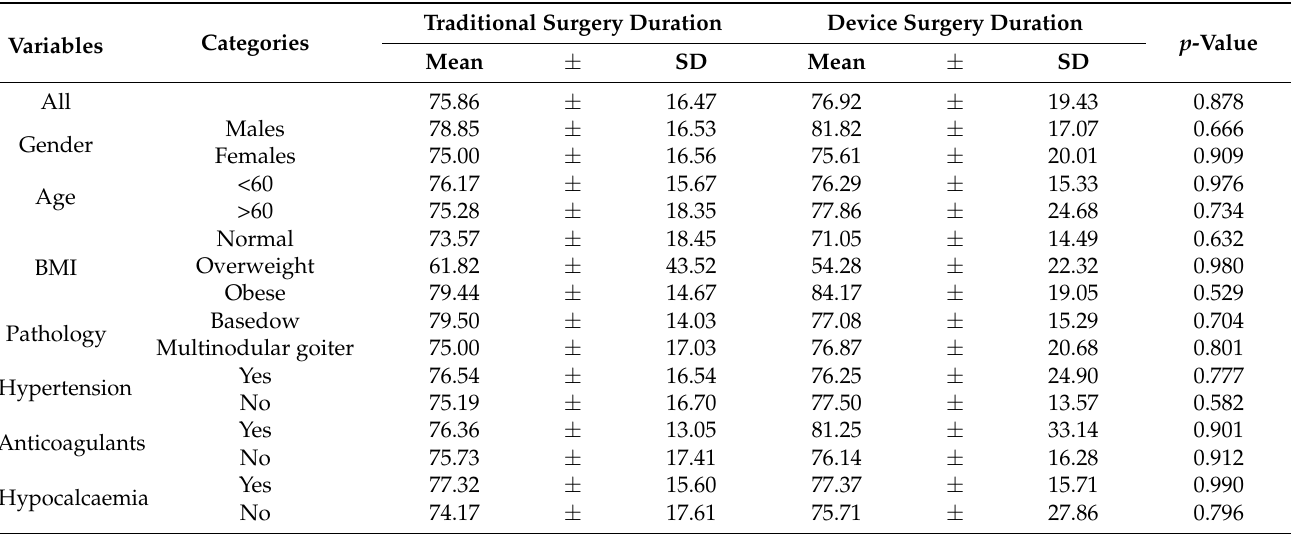
Table 10. Comparison between “Traditional” and “device” groups according to surgery duration. Abbreviation: BMI: Body Mass